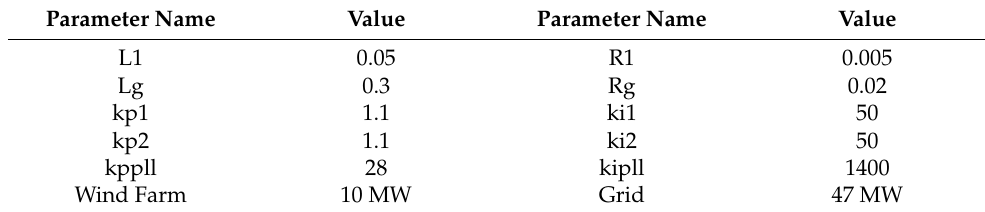
Table A1. The parameters of a wind power system.